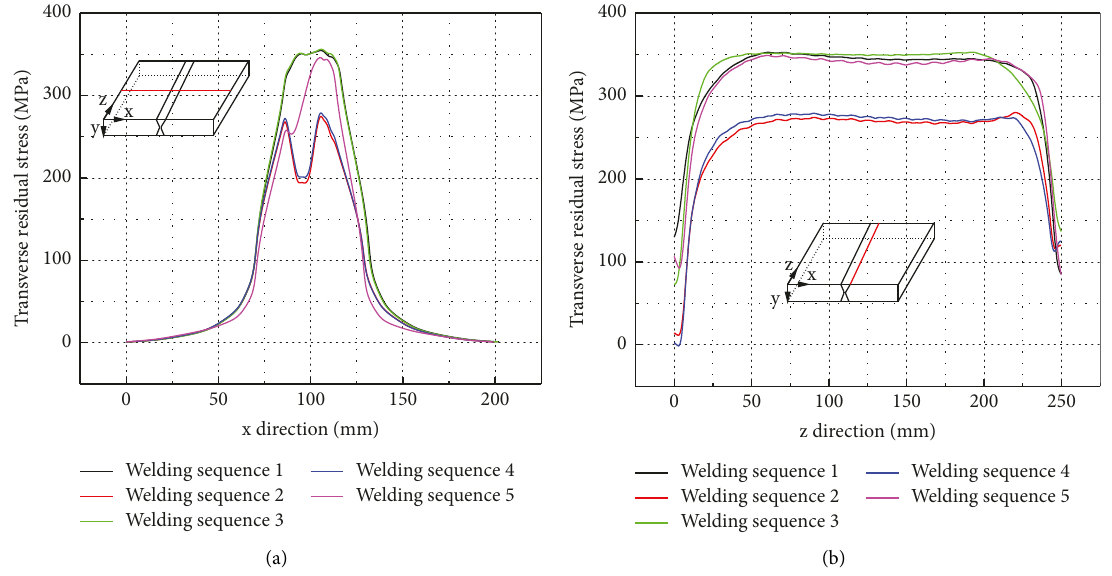
Figure 17: Comparison of the transverse residual stress. (a) Transverse residual stress of path 1. (b) Transverse residual stress of path